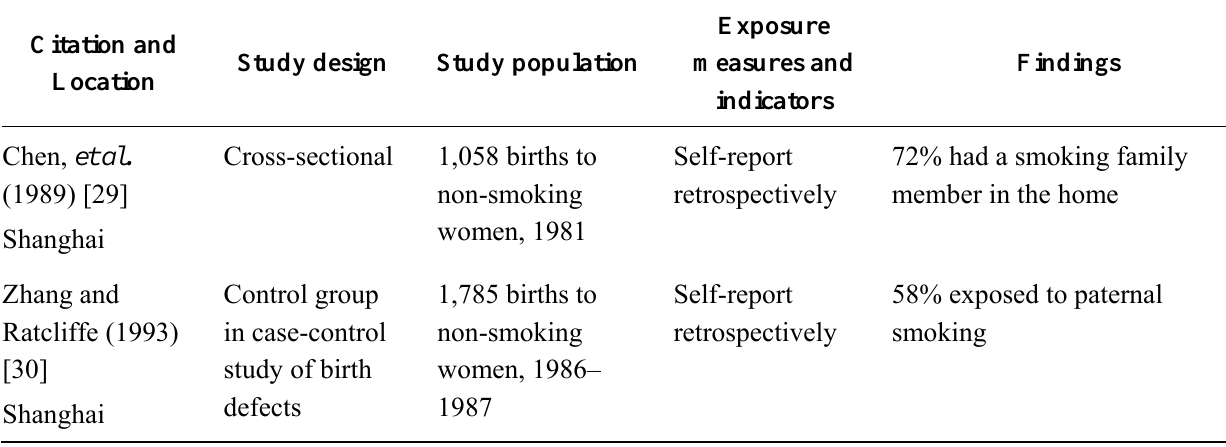
Table 10. Published studies reporting SHS exposure prevalence among women in